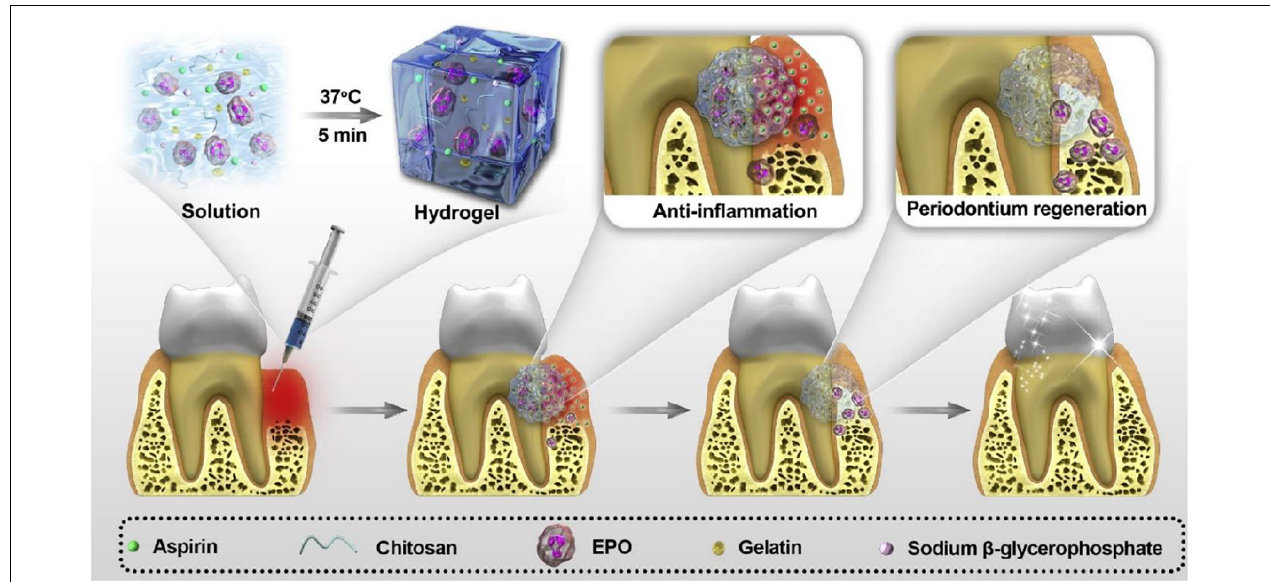
FIGURE 8 | Effect of chitosan/bFGF scaffolds on neural differentiation of DPSCs. Immunofluorescence staining of GFAP, S100 β and β -tubulin III. Reproduced from Zheng et al. (2020) with permission from Copyright 2020 Informa